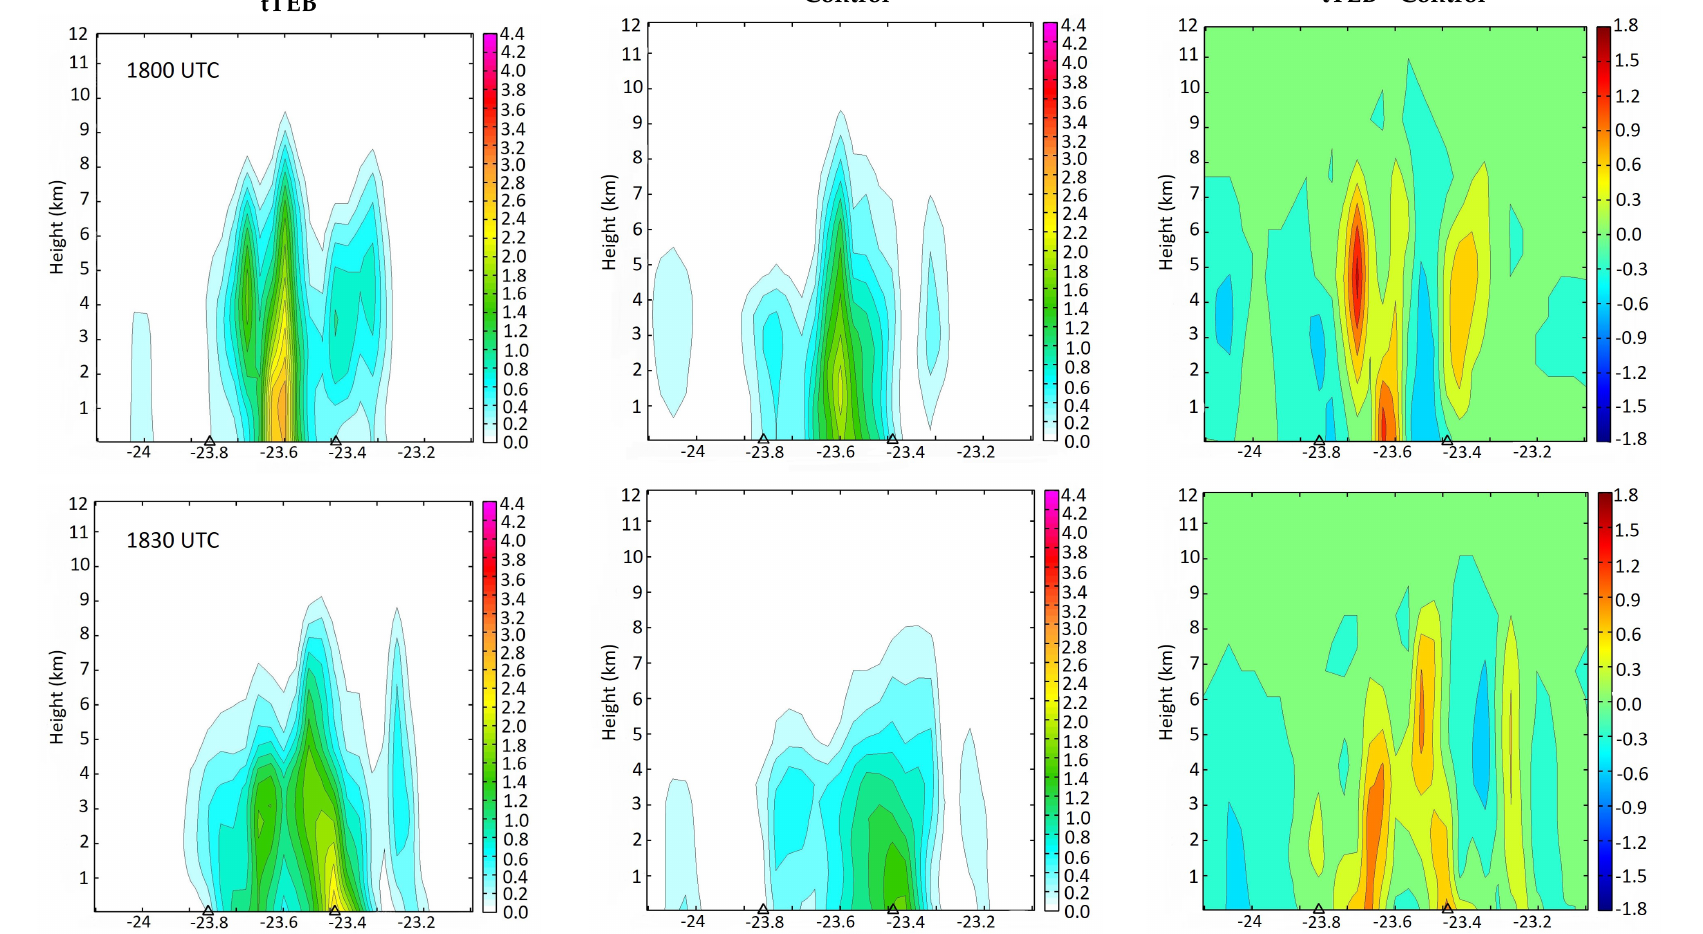
Figure 17. Vertical cross section of mean rain water mixing ratio (g kg − 1 ) between 46.9 ◦ W and 46.42 ◦ W at 18 UTC (15 LT) (first row) and 1830 UTC (1530 LT) (second row) along the latitude. The first column shows the results of the tTEB experiment, the second column shows results of the control experiment and the third column show the differences between both experiments. Triangles indicate the extension of urban canopy of the